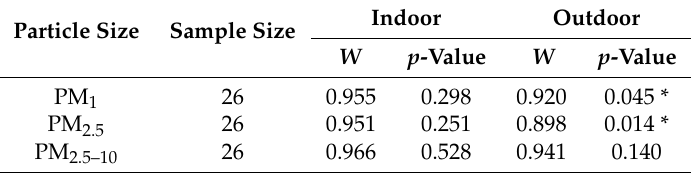
Table 3. Shapiro-Wilk normality test